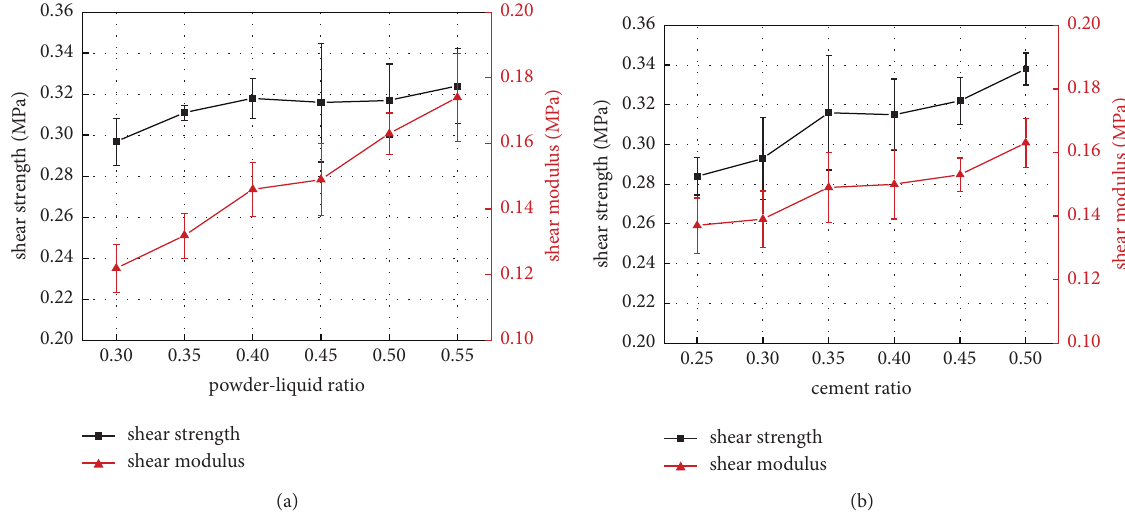
Figure 13: Changes of PCC shear strength indexes with powder-liquid ratio and cement ratio: (a) powder-liquid ratio; (b) cement ratio.